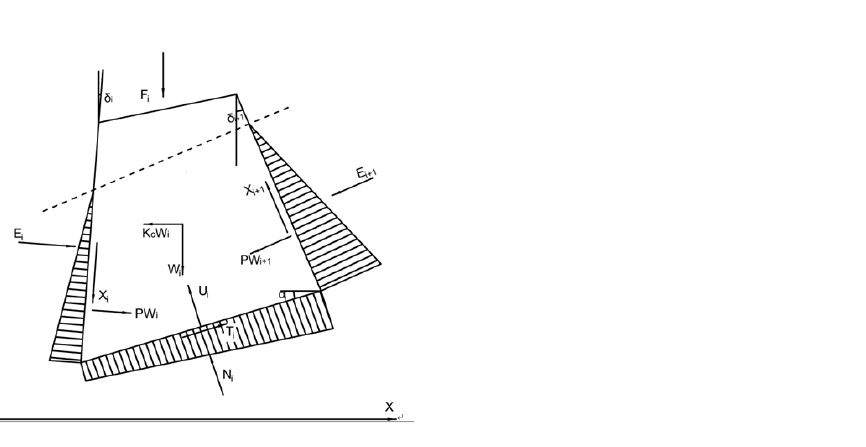
Figure 9. Schematic diagram of the force applied to any block i in the landslide body. According to the principle of static balance, the following Equations (2)–(4) are